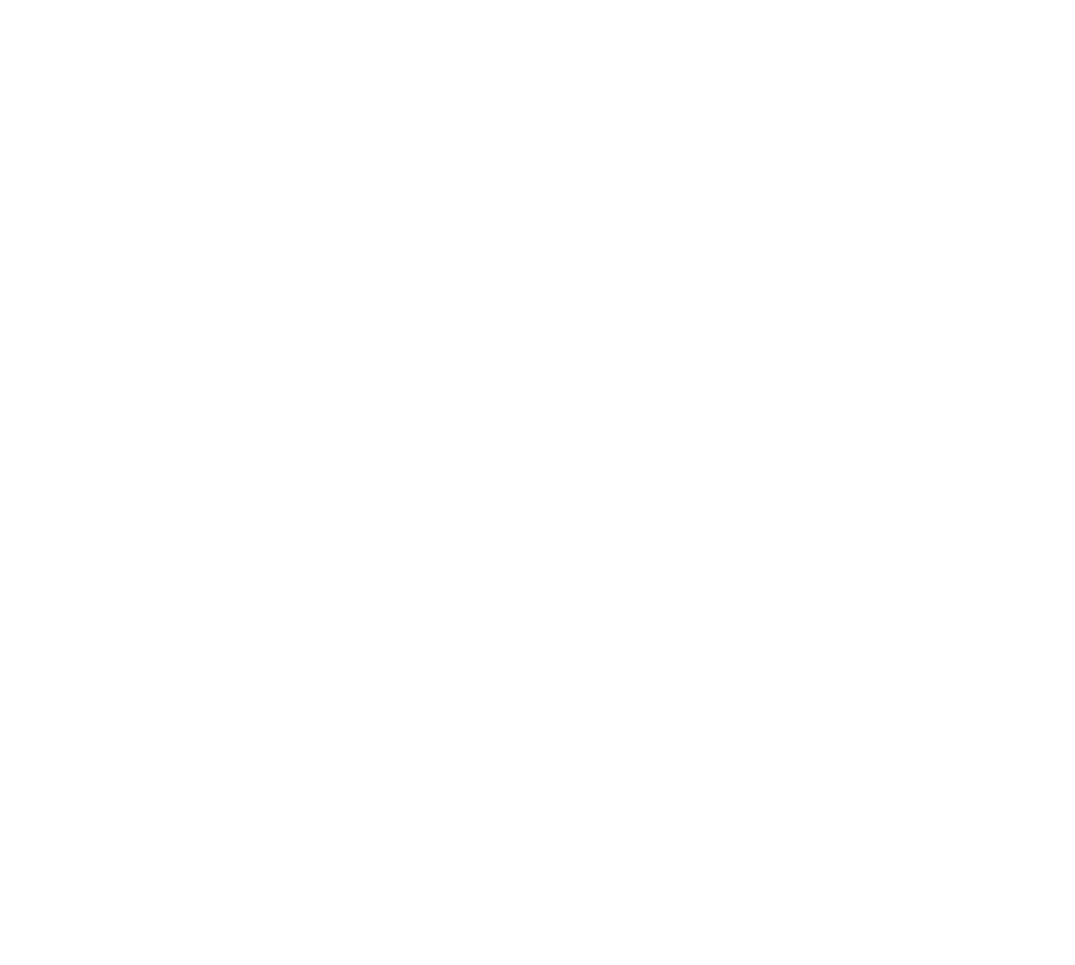
FIGUREA2 |The impact of sampling frequency and duration on our knowledge of microbial disturbance responses in observational and experimental studies (A) and in studies applying press and pulse disturbances (B). Experiments apparently well cover the temporal scales of disturbances anticipated by observational studies (A) and surprisingly there is